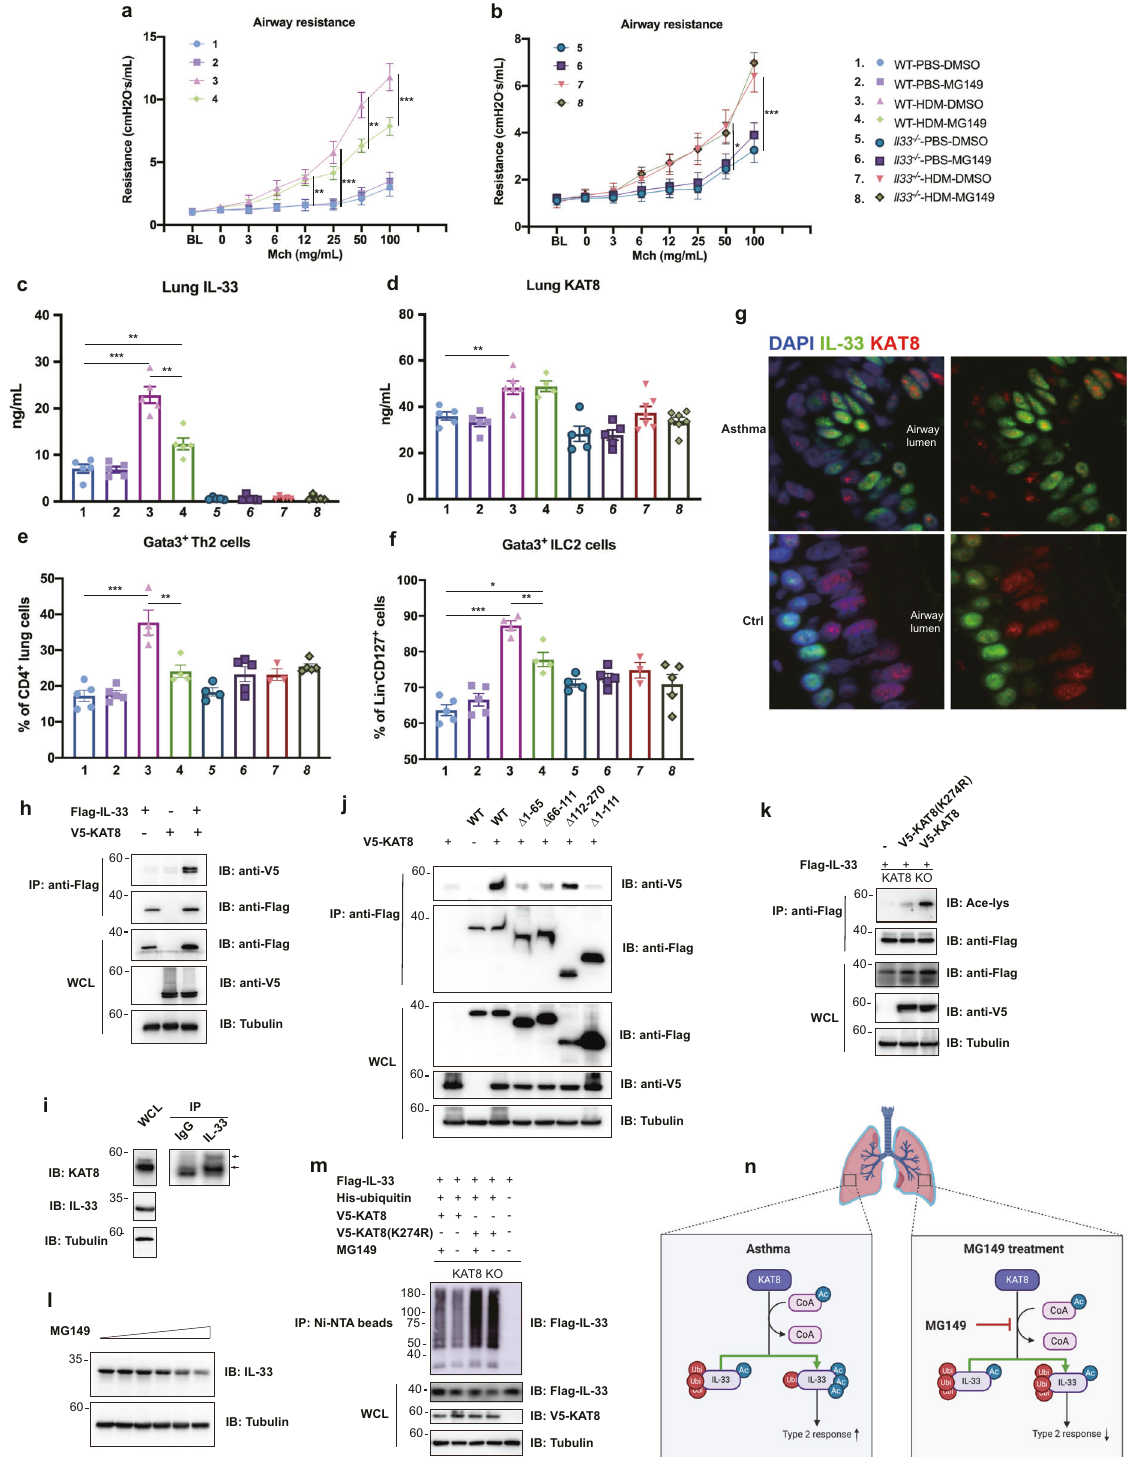
combination with KAT8 (Fig. 1j, Supplementary Fig. S11d, e). Taken together, these fi ndings suggested a speci fi c interaction between IL-33 and KAT8. Since IL-33 could interact with KAT8 and KAT8 is a type of histone acetyltransferase, we then analyzed whether IL-33 was an acetylation substrate of KAT8. It has already been demonstrated that K274R or K274A mutants could decrease the histone Signal Transduction and Targeted Therapy (2021)